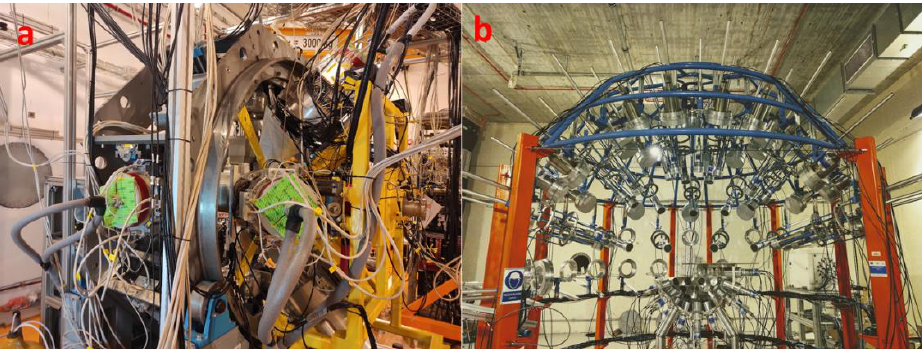
Fig. 1. (a) The ELIADE detector in the E8 experimental hall of ELI-NP, and (b) the ELIGANT-GN detector in the E9 experimental hall of ELI-NP. Photograph courtesy of Dmitry Testov (ELIADE) and Pär-Anders Sӧderstrӧm